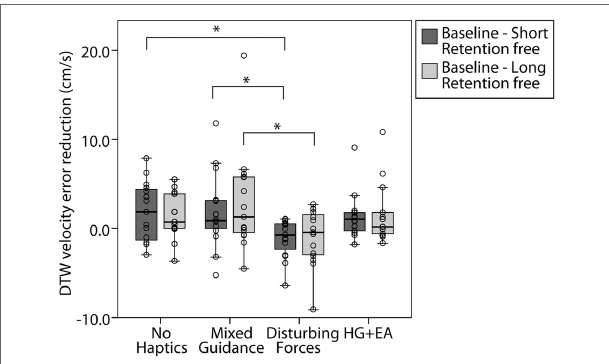
FIGURE 10 | Effect of training strategy on performance without visual feedback . Box-plot of mean DTW velocity reduction from baseline free to short-term retention free (dark gray) and to long-term retention free (light gray). * p < 0.05. Horizontal lines are medians, boxes show the interquartile range (IQR), error bars extent (cid:6) 1.5IQR. Individual data points are plotted as circles.